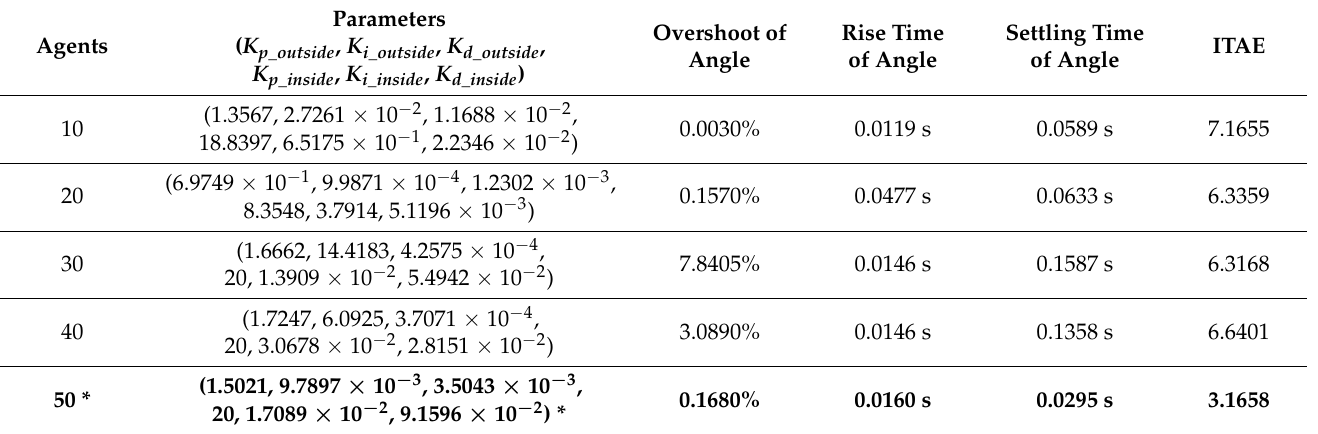
Table 3. Attitude control of balancing robots under HBA-PID algorithm.